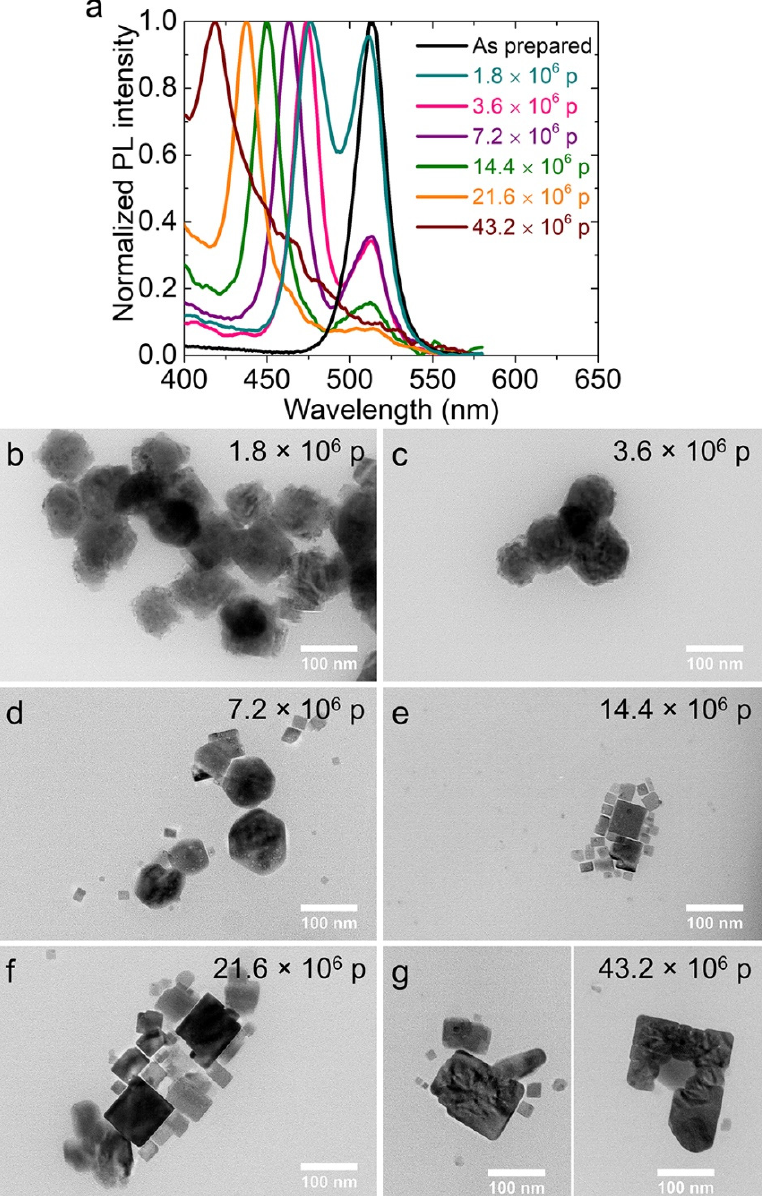
Figure 5. Photoluminescence spectra of the DCB-based nanohexagon solution irradiated with 129 mJ/cm 2 for 1.8 to 43.6 × 10 6 number of pulses ( a ). Low magnification TEM images of the irradiated nanocrystals for the same irradiation durations ( b – g ). The Figure 5g are two particles from two different TEM grid regions. The irradiation was carried out with a fs laser of 513 nm